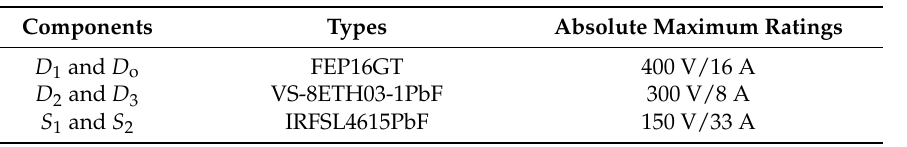
Table 3. Semiconductor devices used in the prototype.